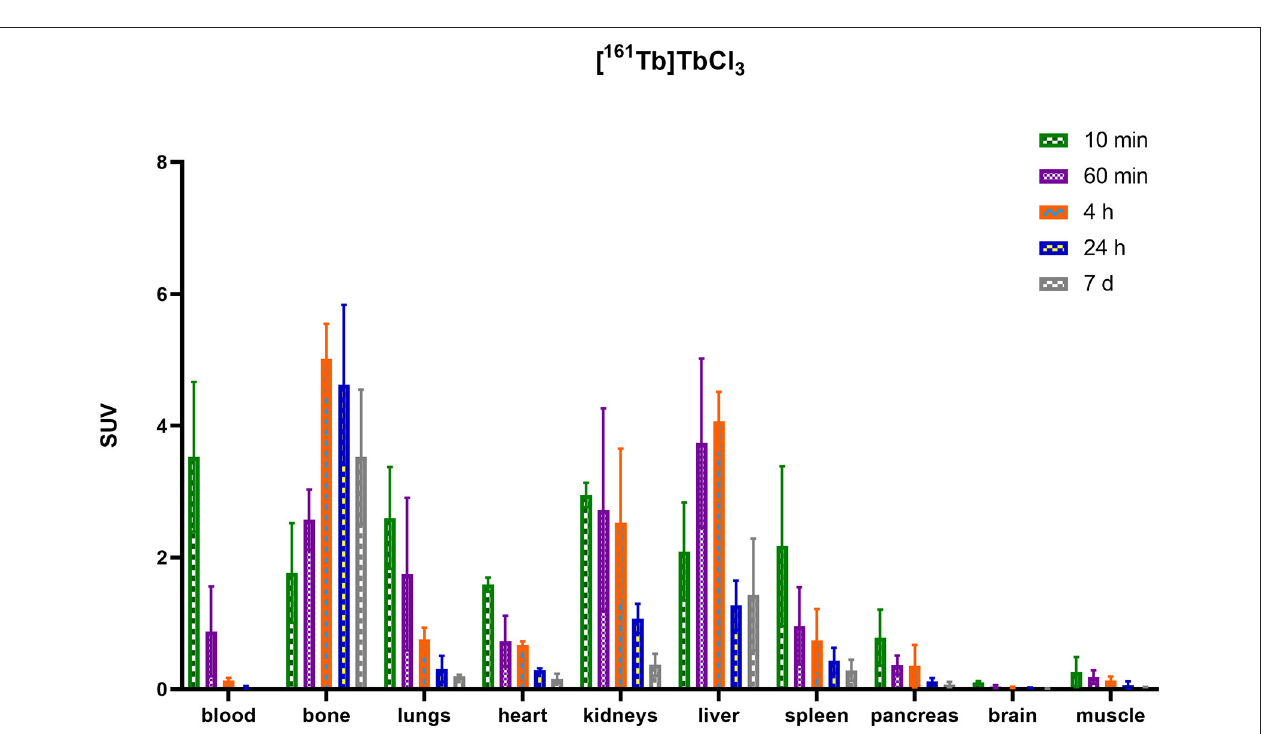
FIGURE 5 | Biodistribution of [ 161 Tb]TbCl 3 expressed in standardized uptake values per organ.